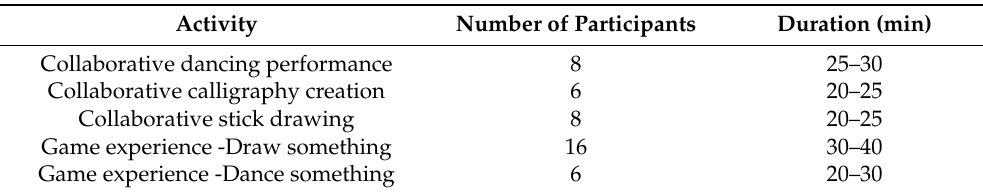
Table 2. Activities of